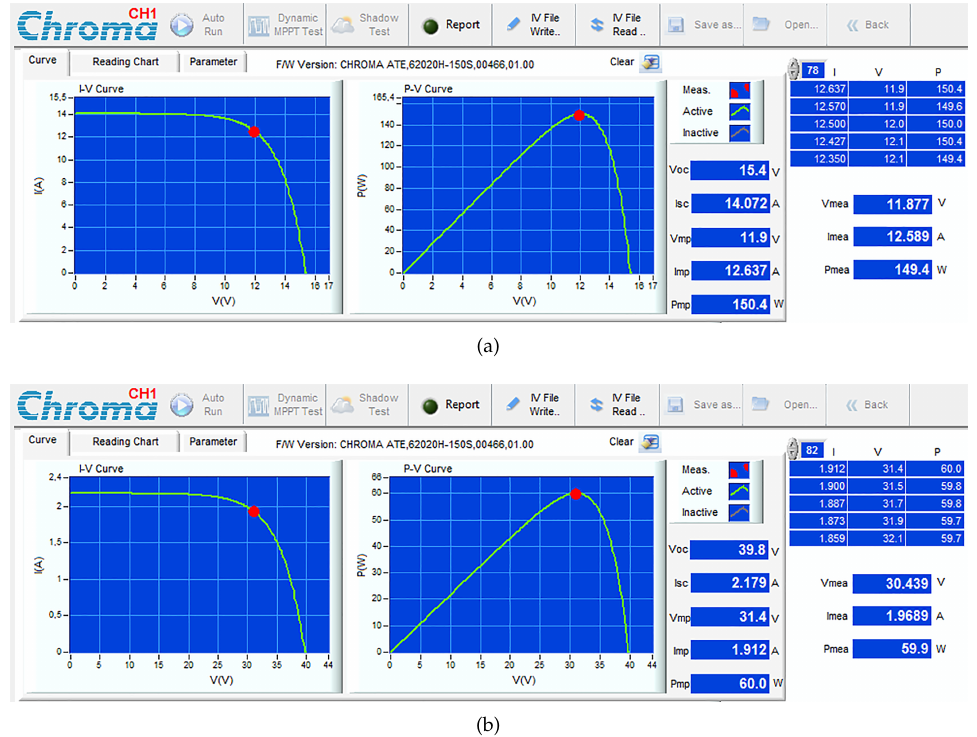
Figure 6. ( a ) MPPT performance in the emulation of a 150.4 W PV panel, ( b ) MPPT performance in the emulation of a 60 W PV